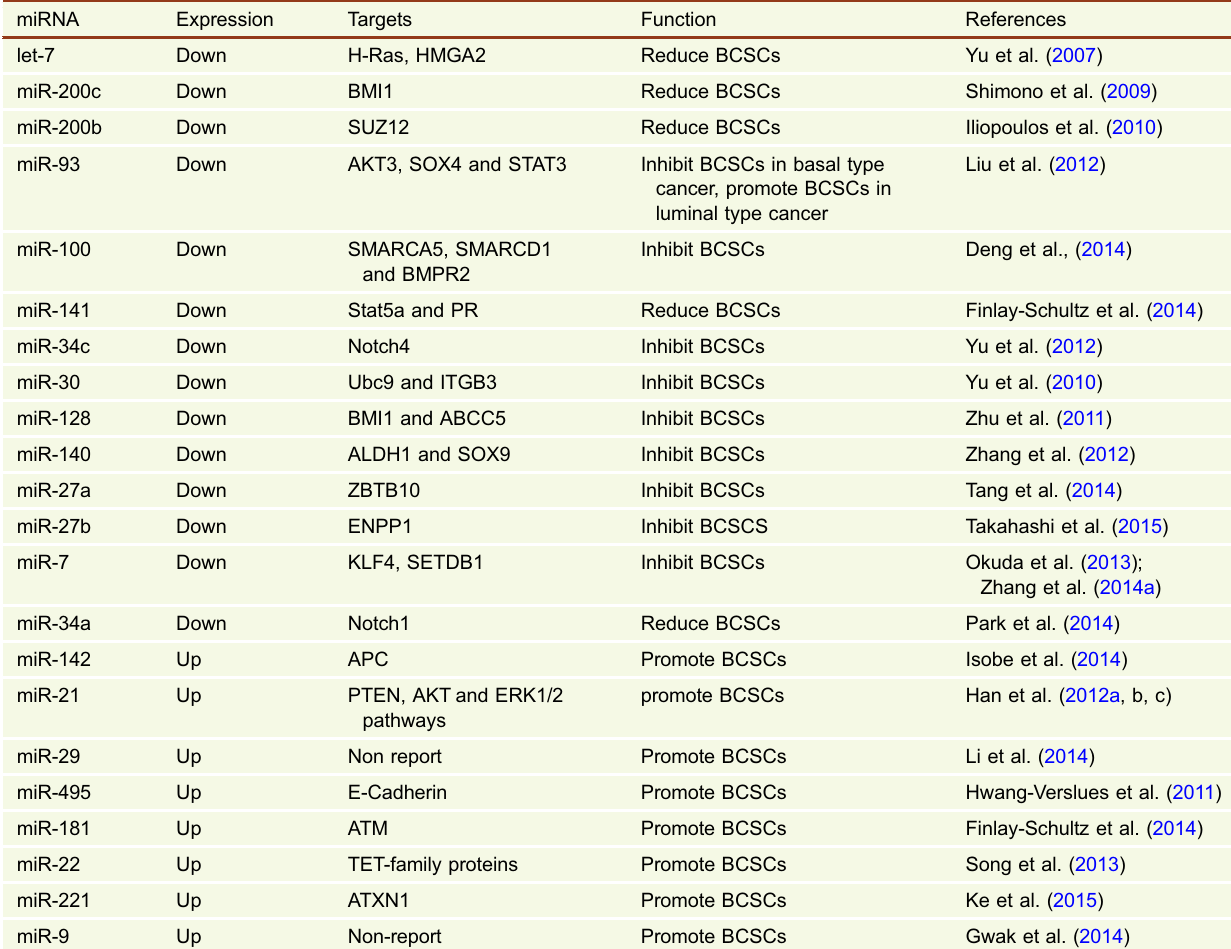
Table 1. miRNAs aberrantly expressed and validated target genes in BCSCs